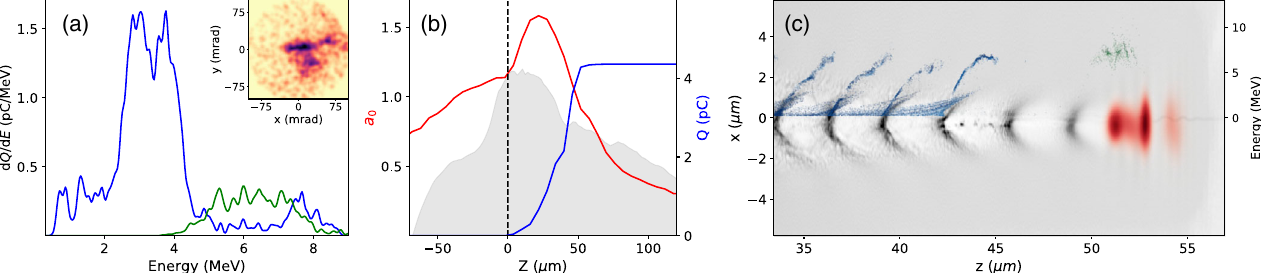
FIG. 7. PIC simulations. (a) Final energy spectra of electrons produced from L-shell (blue curve) and K-shell (green curve) of nitrogen atoms, with energies > 300 keV and within 100 mrad aperture; electron angular distribution (inset); (b) Evolution of the peak normalized laser field eE l =m e c ω 0 , and electron charge of the beam selected from (a); gray area represents the adjusted plasma density profile in arbitrary units. (c) Electron density (gray color) in z – x plane, and in phase space z − ε z for L-shell and K-shell electrons (blue and green respectively) and 2D laser envelope (red